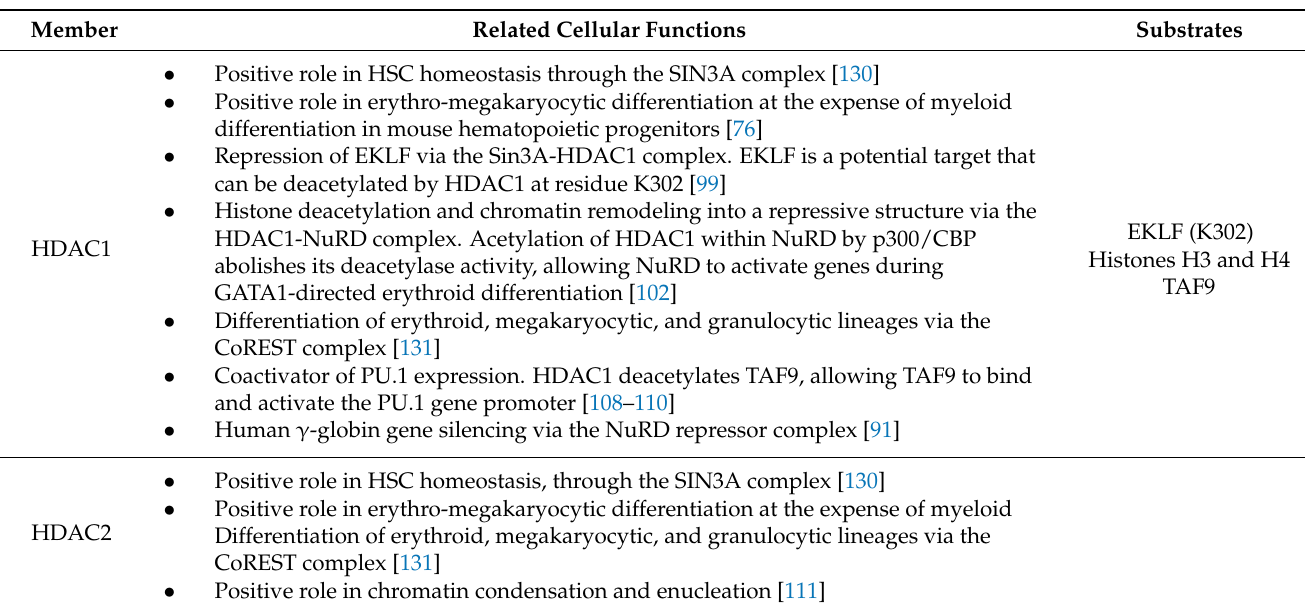
Table 2. Cellular functions of HDACs involved in hematopoiesis and associated potential substrates. Related Cellular